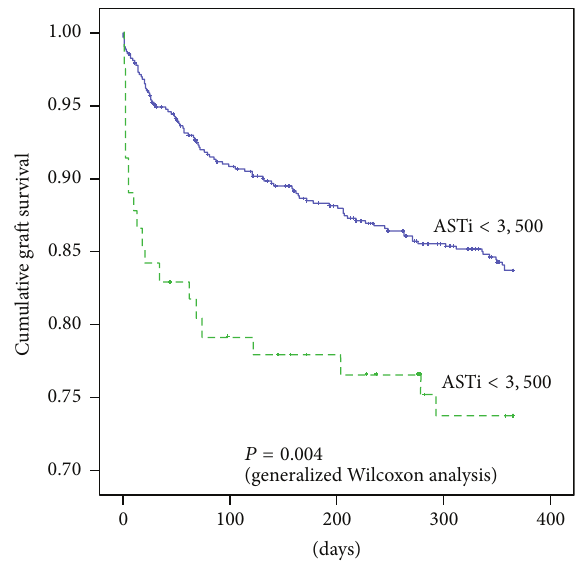
Figure 4: Significant reductions in one-year graft survival in patients with ASTi > 3,500 IU/L compared to patients with ASTi < 3,500 IU/L. Kaplan-Meier survival analysis showed the probability of primary graft outcome among patients who had a peak-adjusted AST (ASTi) of greater than 3,500 IU/L along with those who had ASTi of less than 3,500 IU/L. The probability of event-free graft survival at 1 year was 0.576 in the ASTi > 3,500 IU/L group and 0.487 in the ASTi < 3,500 IU/L group. There was a significant reduction in graft survival in ASTi > 3,500 IU/L